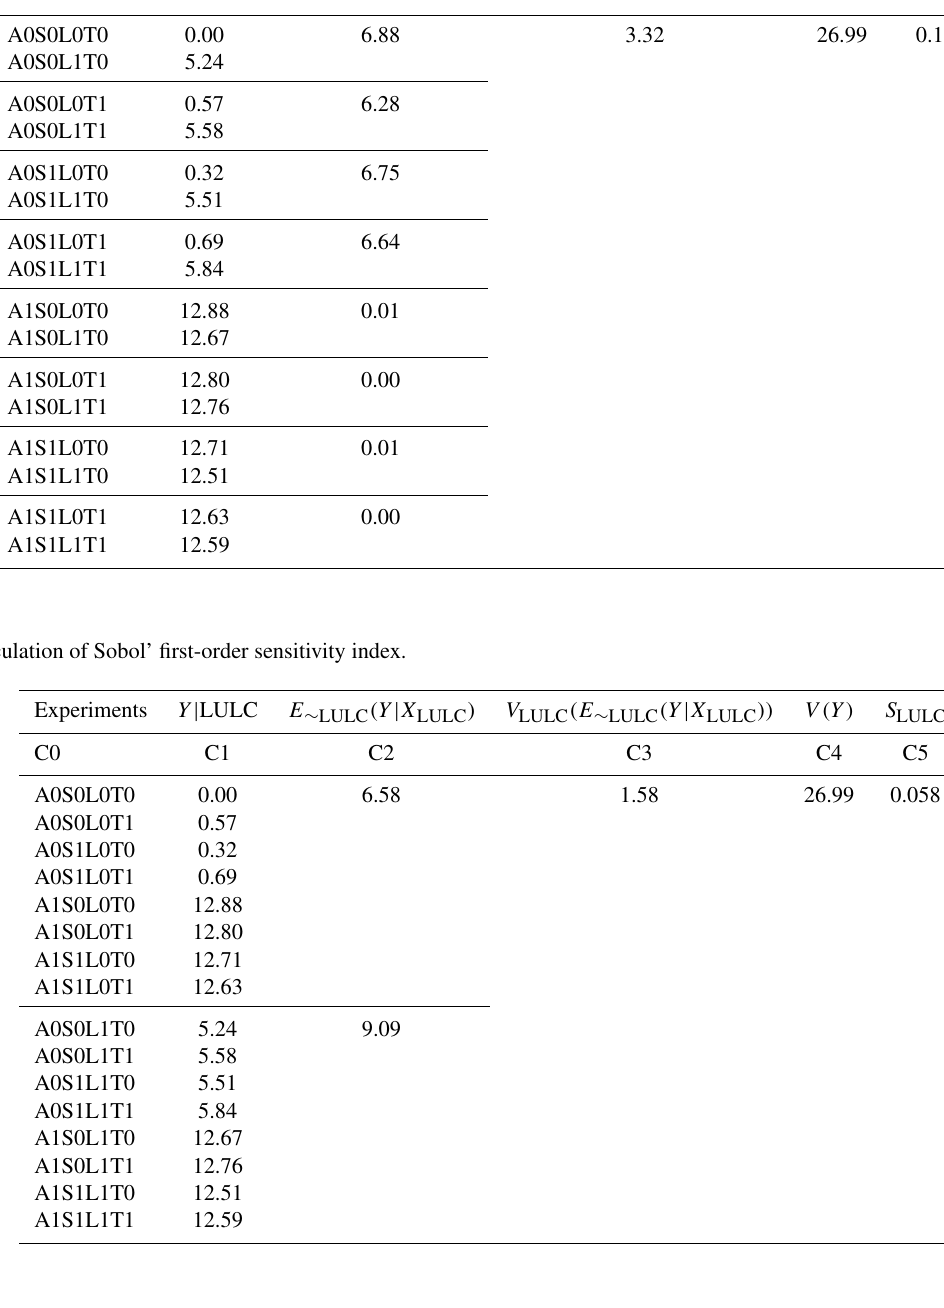
Table A3. Calculation of Sobol’ interaction effect index and contributing